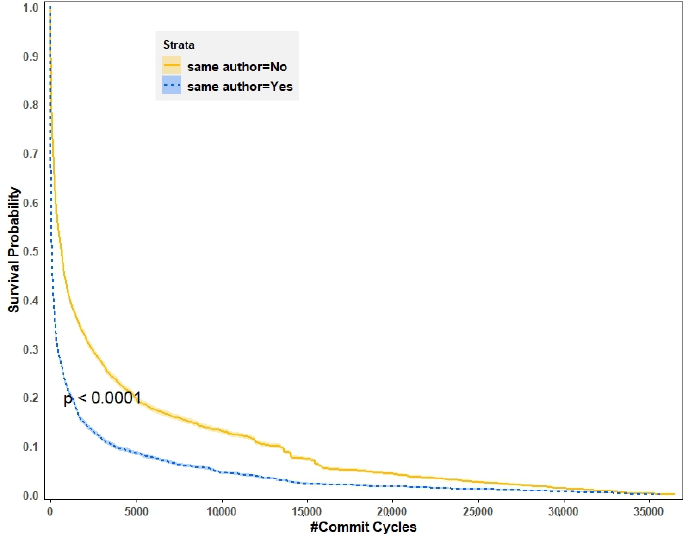
Figure 5. Kaplan–Meier estimations of the survival function for the scenario when bugs are fixed by developers who also introduced them and vice